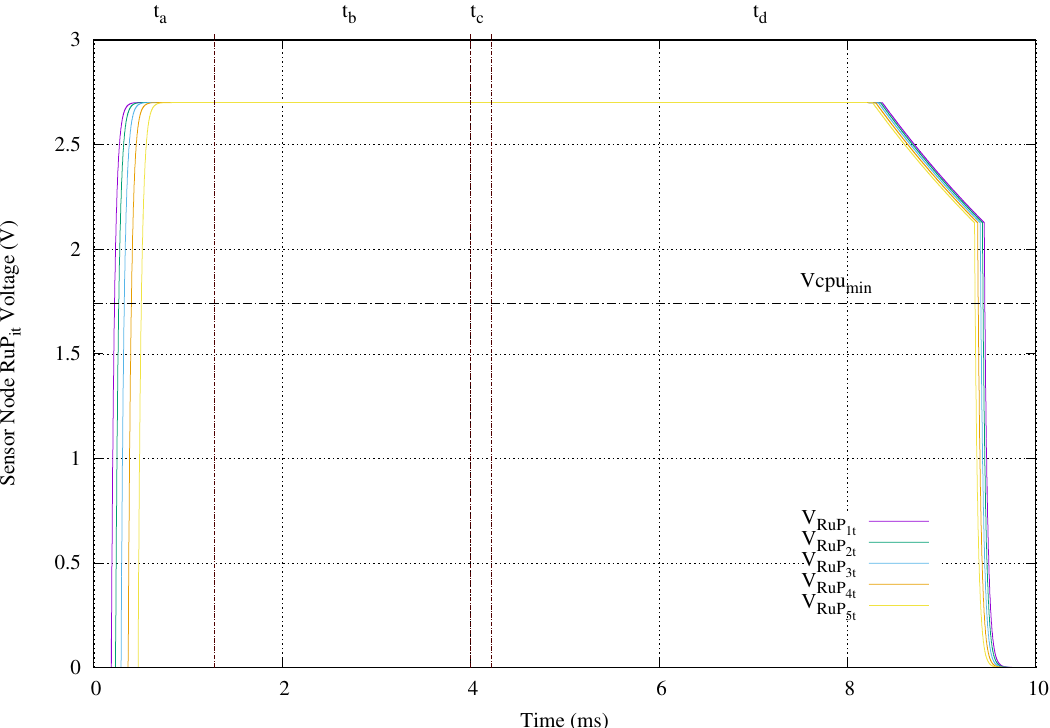
Figure 12. Microcontroller voltage ( V RuP